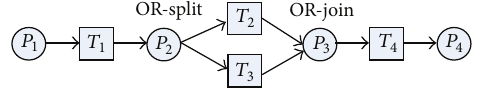
Figure 8: Selective routing.